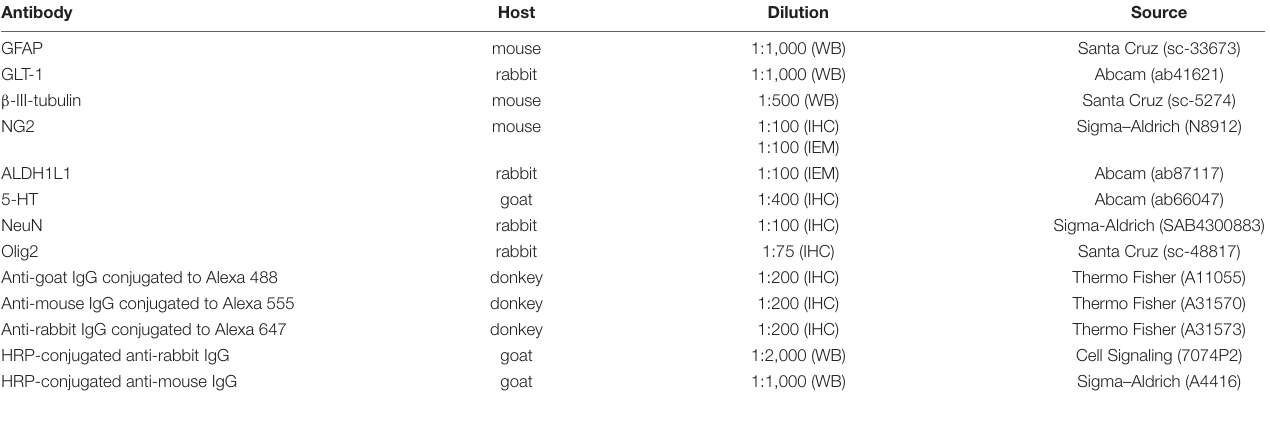
TABLE 1 | Primary and secondary antibodies used in Western blotting (WB), immunohistochemistry (IHC), and immunoelectron microscopy (IEM) tests. Antibody Host